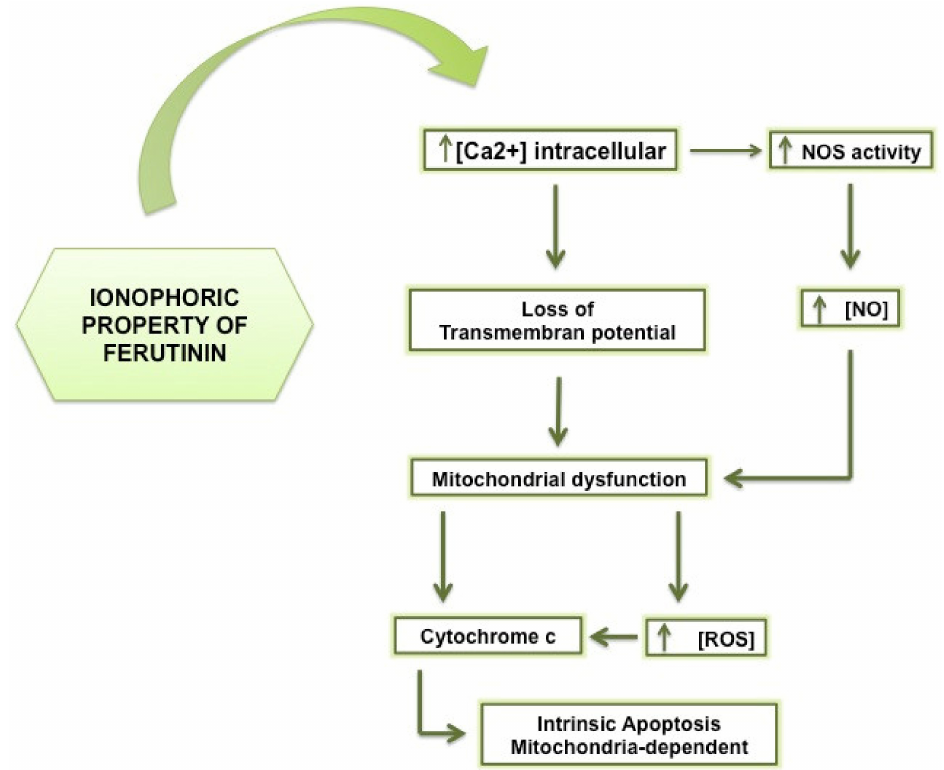
Figure 3. The ionophoric property of sesquiterpene ferutinin. Ferutinin, thanks to its ionophoric activity leads to loss of transmembrane potential and the subsequent apoptosis